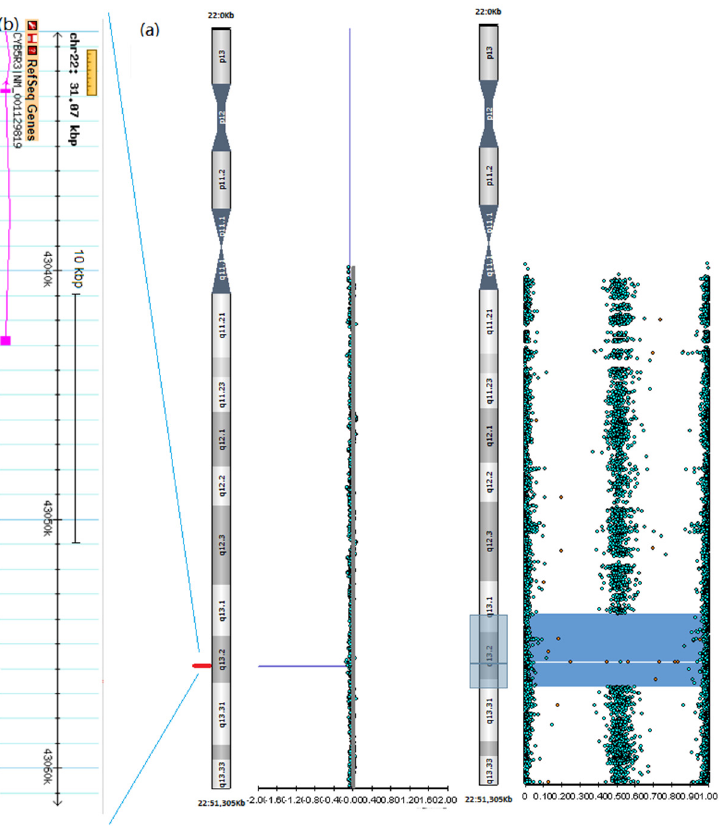
Figure 3. SNP-array analysis output from BlueFuse Multi software. ( a ) A 5 Mb ROH (Run of Homozygosity) is shown as a gray area on the ideogram of chromosome 22. The CNV (Copy Number Variant) and BAF (B allele frequency) graphs are reported on the left and on the right side, respectively. Homozygous deletion is represented as red non-classified spots on the BAF graph and as a red line on the CNV graph. ( b ) Enlargement of the 22q13.2 homozygous deletion, involving the first two exons of CYB5R3 .